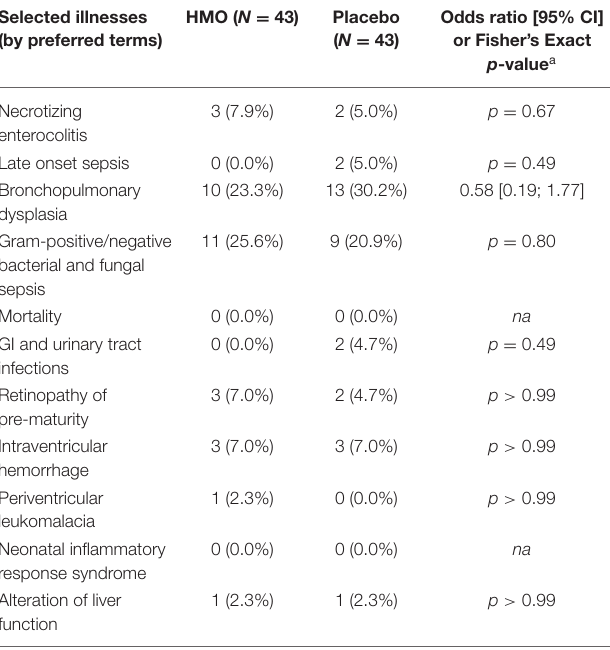
TABLE 4 | Incidence of infant illnesses and infections from baseline to discharge. Selected illnesses HMO ( N = (by preferred terms)